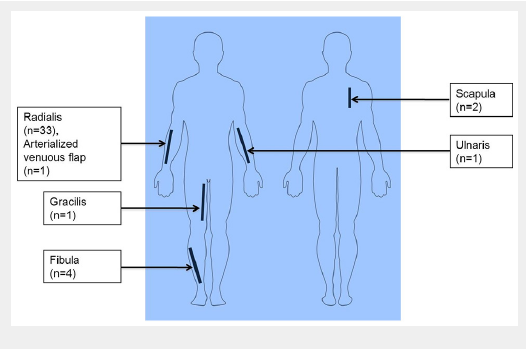
Distribution of flap donor sites in all reviewed patients undergoing microvascular free tissue